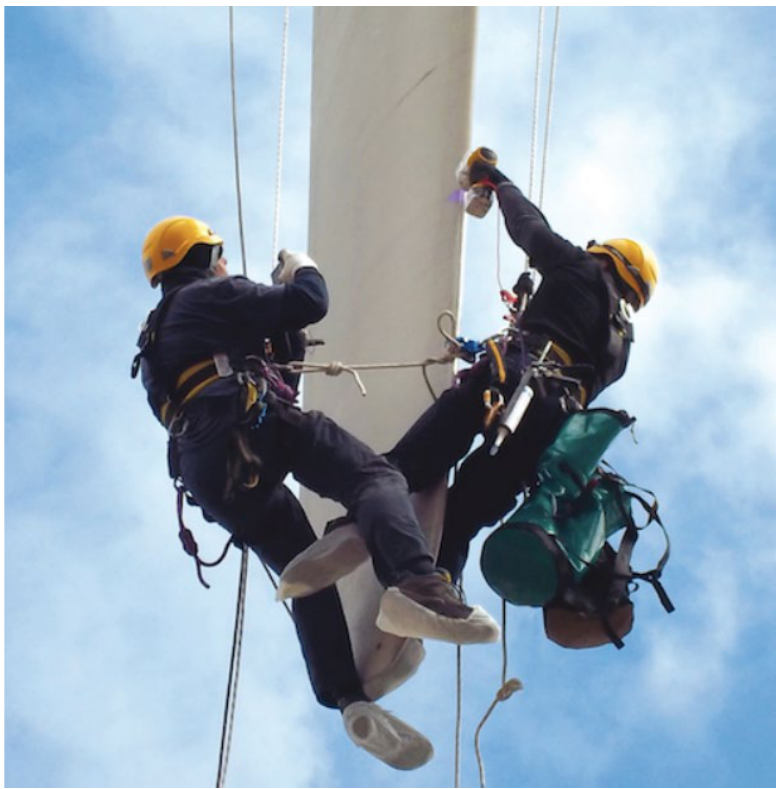
Figure 9. Visual inspection by rope